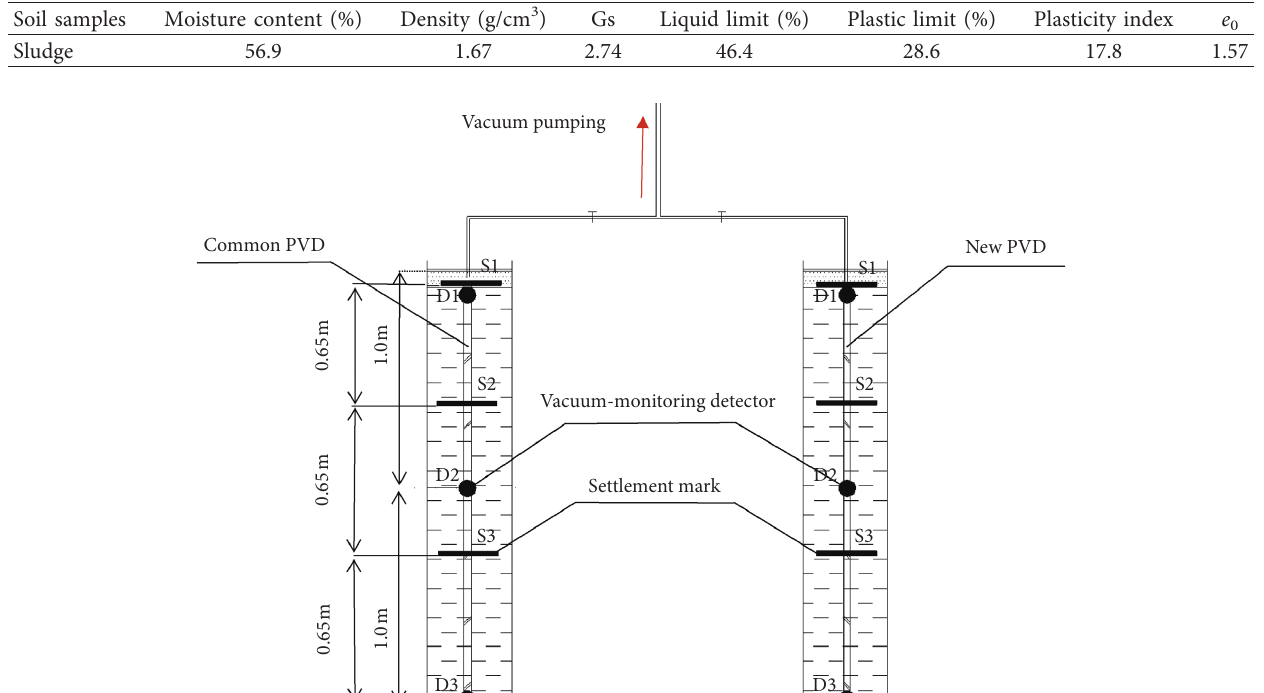
Table 1: Basic physical and mechanical properties of soil samples.